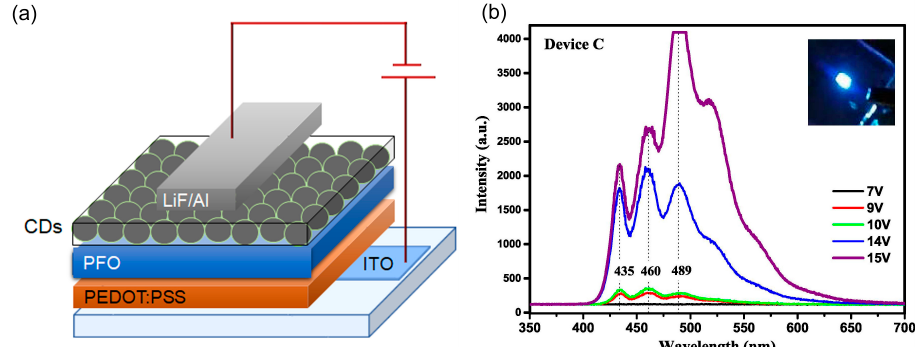
Figure 23. ( a ) Scheme of the device architecture and ( b ) EL spectra as a function of operating voltage: Reproduced with